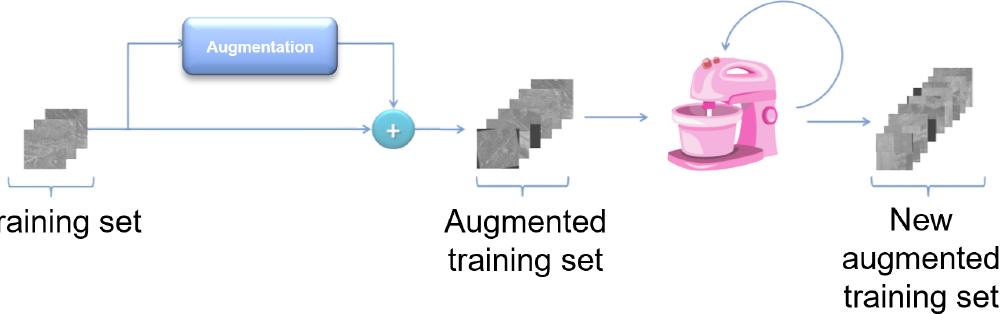
Figure 12. Schematic representation of augmentation pipeline.